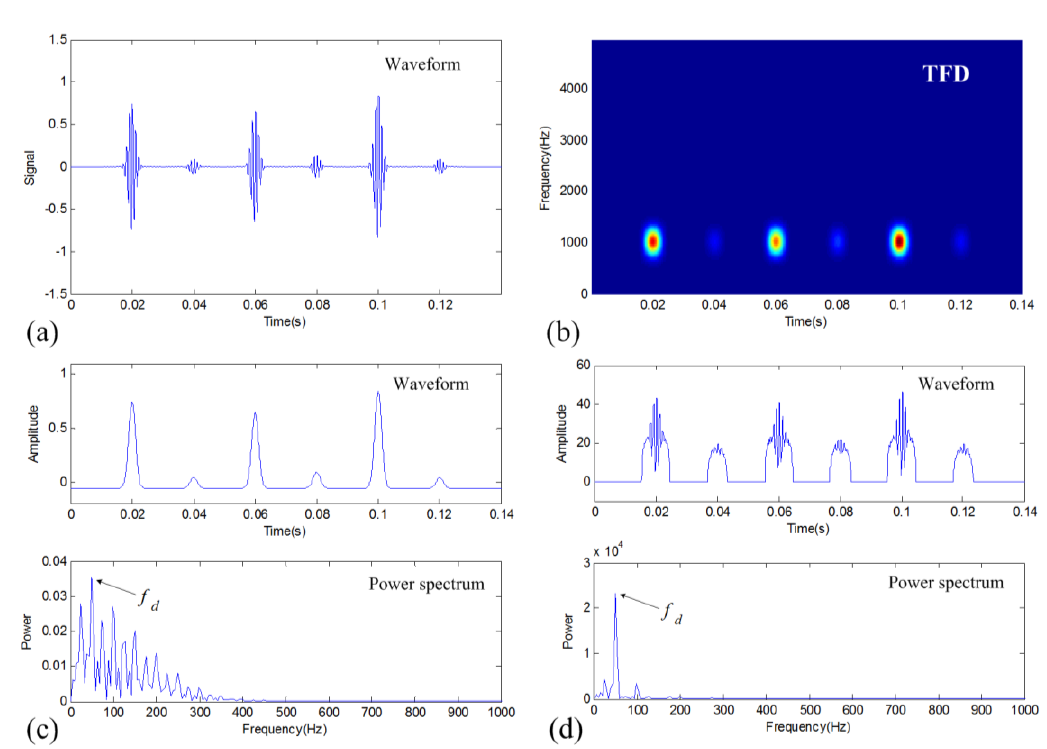
Figure 4. Demonstration of the FPTS spectral analysis for a simulated signal with periodic impulses of different intensities: ( a ) waveform; ( b ) the TFD; ( c ) envelope spectrum; and ( d ) FPTS